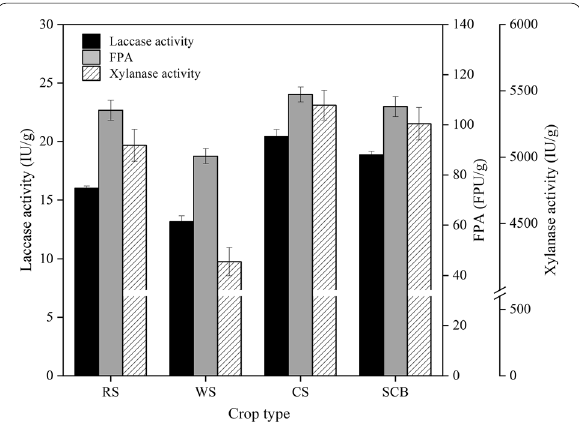
Fig. 1 Effect of crop type on enzyme production by T. reesei ZJ-09 under SSF. All samples are collected on day 10 to assay the FPA, xylanase activity, and laccase activity. Data were average values of triplicate samples and error bars indicate standard